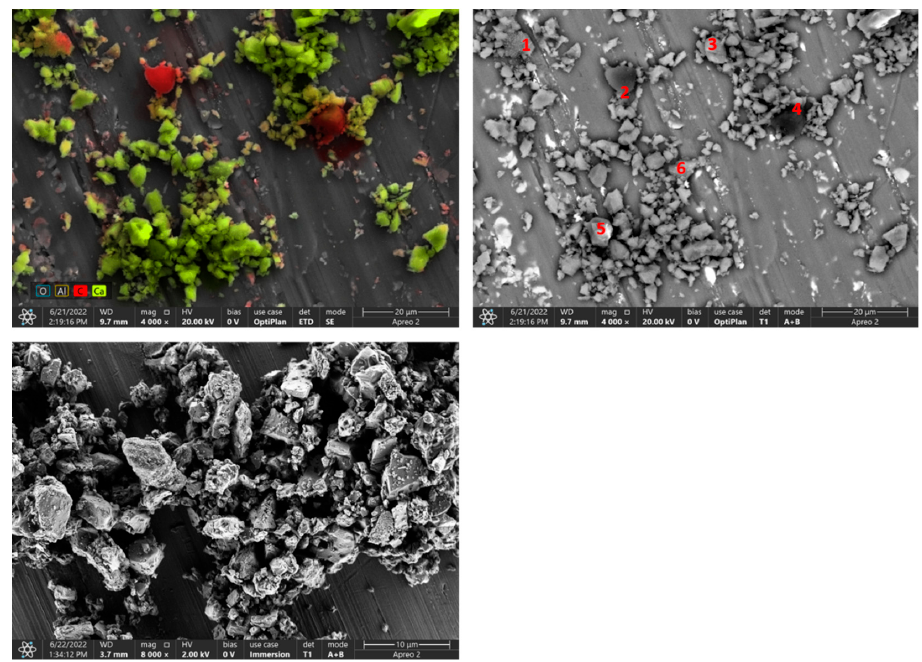
Figure 4. SEM-photographs and EDS analysis of sample A of calcite contaminated with waste toner powder (red numbers mark EDS analysis points). Table 2. Results of EDS analysis of sample A.